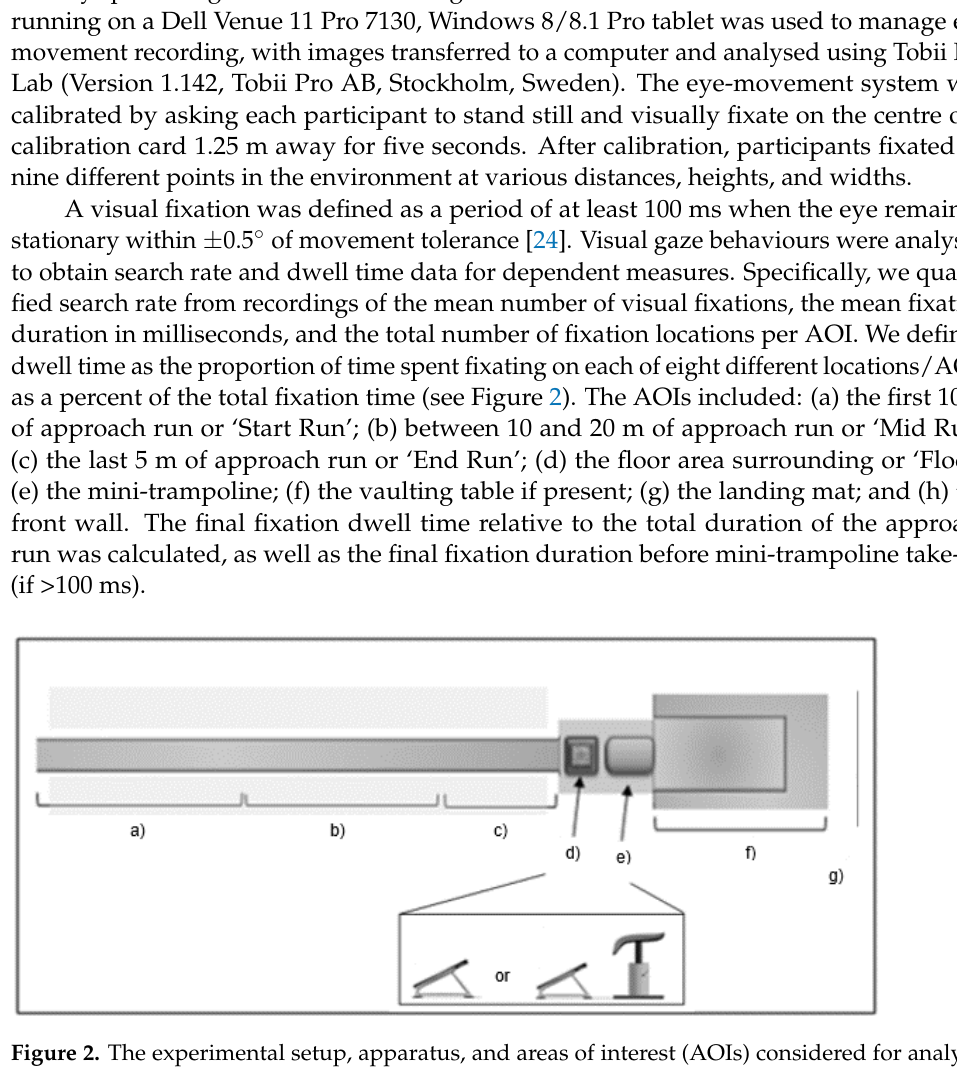
Figure 2. The experimental setup, apparatus, and areas of interest (AOIs) considered for analysis. areas); ( d ) mini-trampoline; ( e ) vaulting table; ( f ) landing mat (4 × 7 m); and ( g ) front wall. Lateral view is presented at the bottom of the figure for each apparatus and AOIs: mini-trampoline without vaulting table (MT) and mini-trampoline with vaulting table (MTVT). Adapted from Hughes et al. (2013).